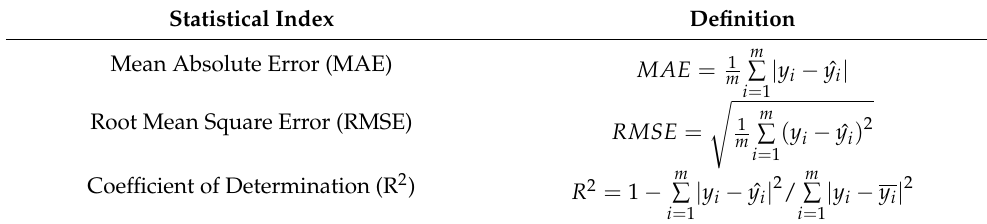
Table 1. Model performance evaluation indicators.